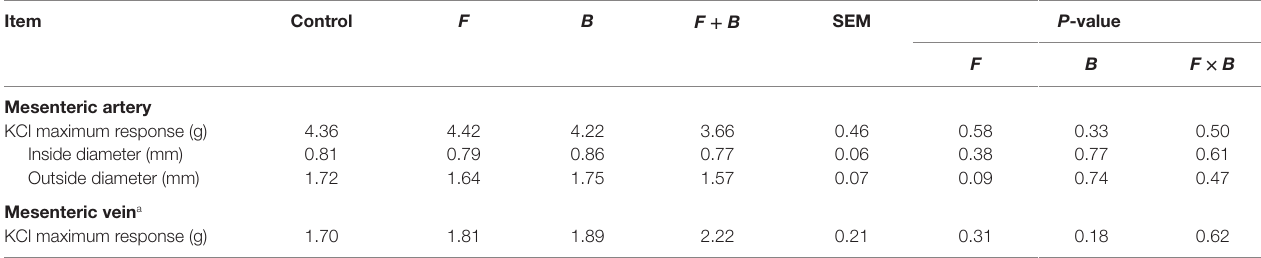
TaBle 1 | inside diameter, outside diameter, and seM of mesenteric artery, and the mean Kcl maximum response of mesenteric artery and vein to pretreatment without tall fescue extract: only Krebs–henseleit buffer (control); 1 × 10 − 6 M treatments of formononetin ( F ), biochanin a ( B ), and combination of F and B ( F + B ).